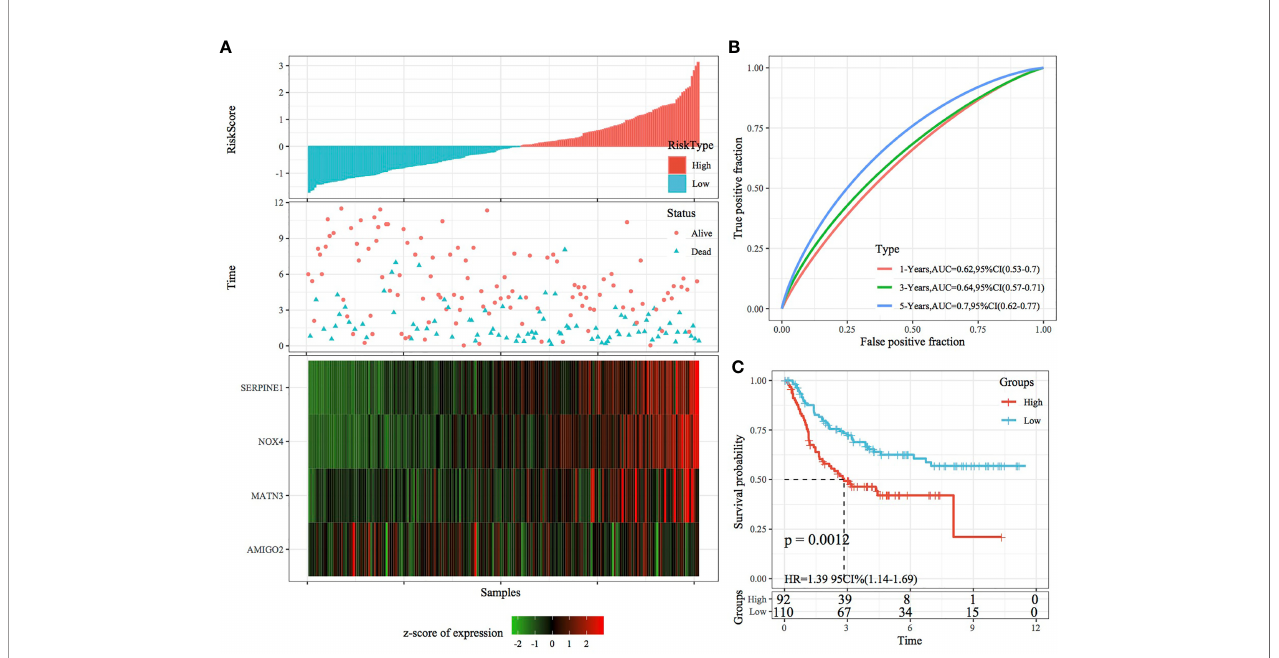
FIGURE 10 | Validation of the four-gene signature in the GSE26942 dataset. (A) RiskScore, survival status and the expression of four genes in the independent validation dataset GSE26942. (B) ROC curve and AUC of the four-gene signature. (C) KM curve demonstrating survival predicted by the four-gene signature in the independent validation dataset